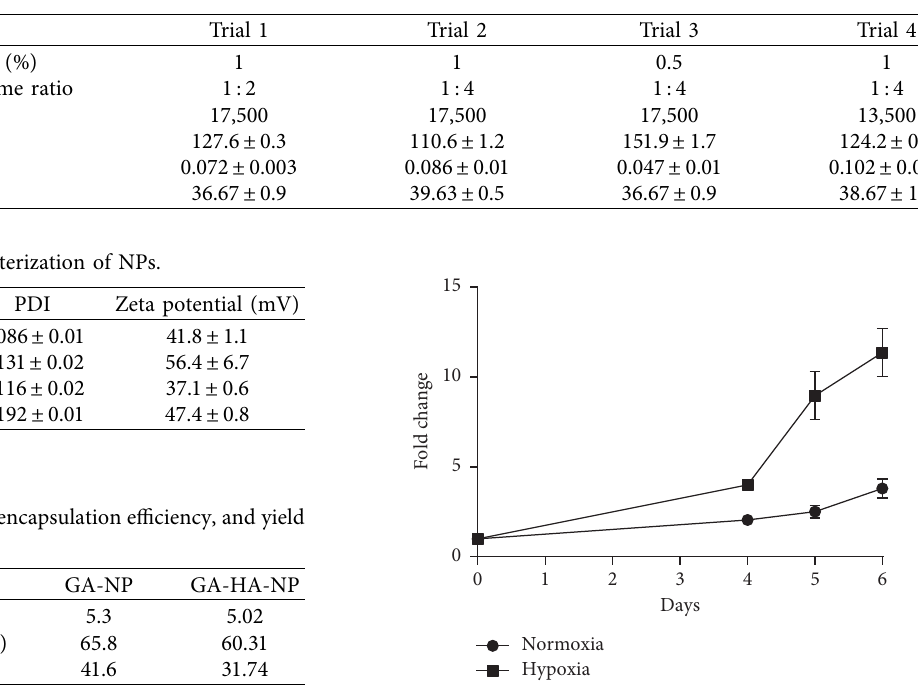
Table 2: Effects of variables (DMAB concentration, organic to aqueous phase volume ratio, and homogenization speed) on NP characteristics.